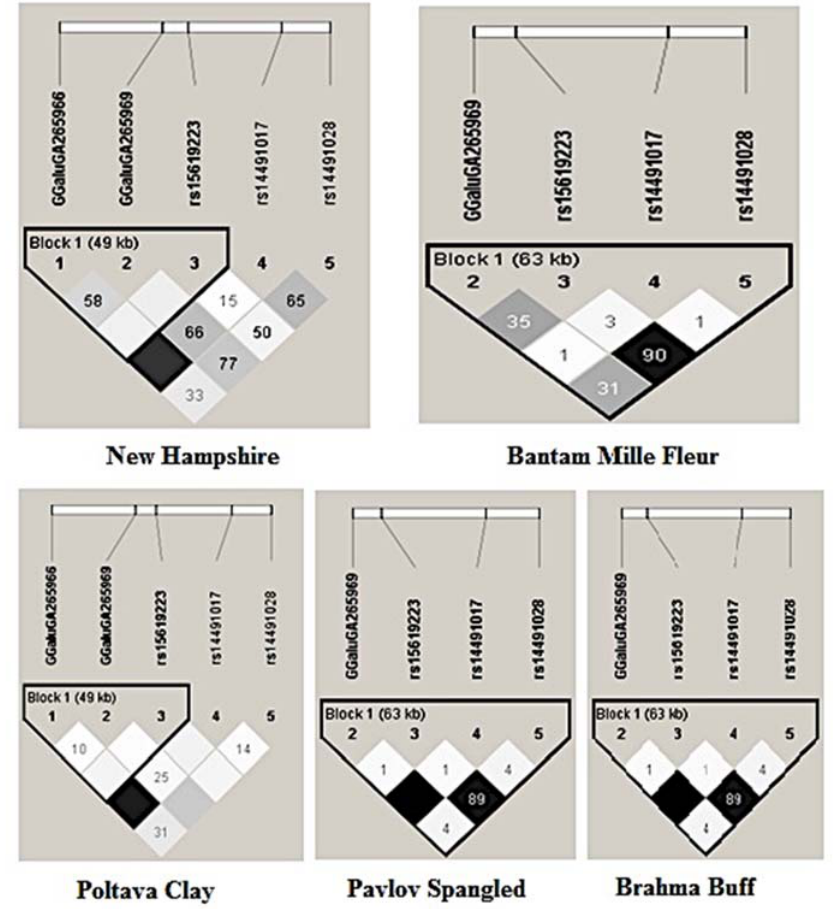
Figure 4. Structure of linkage disequilibrium at the LCORL gene in the 11 studied chicken populations using Haploview 4.2. The color scheme represents a linkage rate between the SNPs: white, no linkage ( r 2 = 0); light gray, slight linkage (0 < r 2 ≤ 0.5); dark gray, strong linkage (0.5 < r 2 <1); black, full linkage ( r 2 = 1).